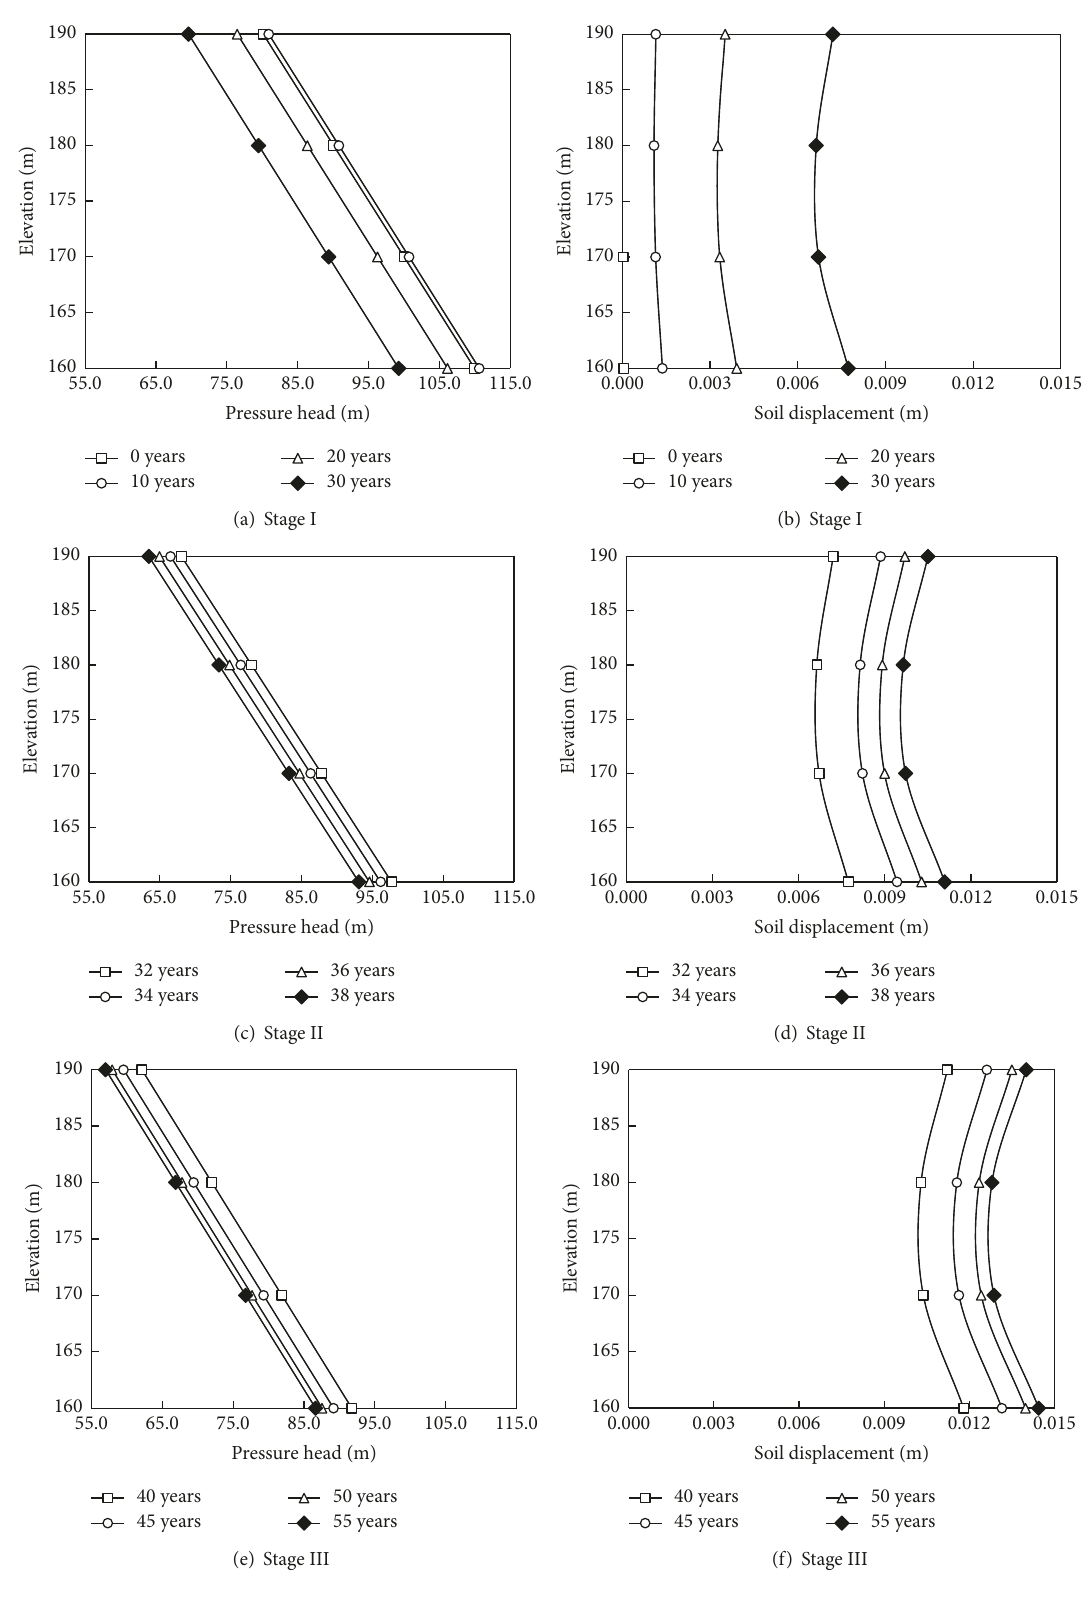
Figure 4: Distributions of pressure head and soil displacement in confined aquifer I during different